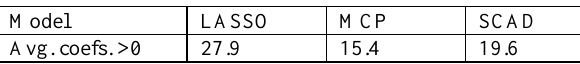
Table 2. Average number of nonzero coefficients of